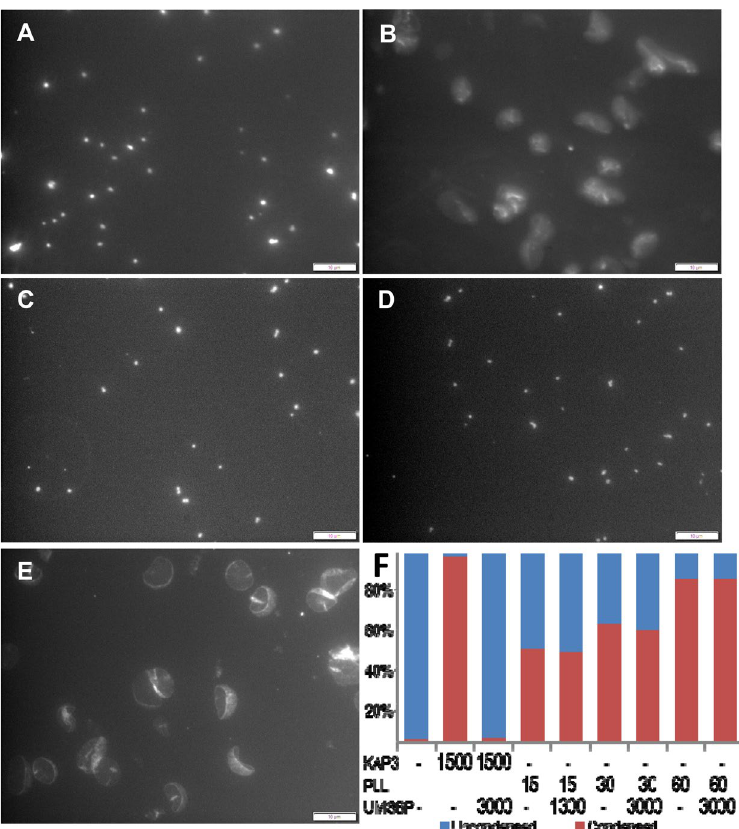
Figure 2. Condensation of kDNA networks by KAP3 and poly L-lysine and their remodeling by UMSBP. DAPI stained isolated kDNA networks, as visualized by fluorescence microscopy, after condensation assays: (A) In the presence of 1500 nM KAP3, followed by (B) treatment with 3000 nM UMSBP. (C) In the presence of 60 nM PLL, followed by (D) treatment with 3000 nM UMSBP. (E) No protein added. (F) The percent of uncondensed and condensed networks was calculated using ~ 600 networks counted for each condensation assay indicated in the